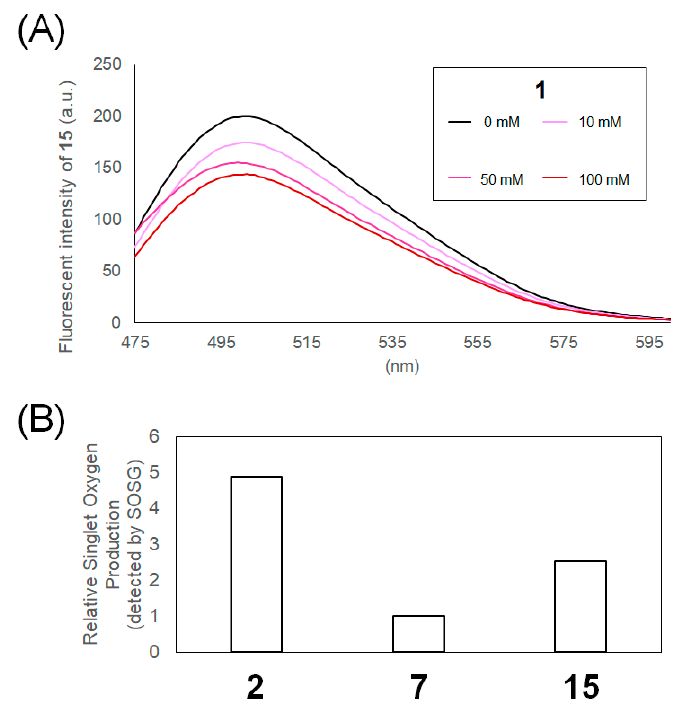
Figure 3. Single-electron transfer (SET) and 1 O 2 production properties of photocatalysts. ( A ) Stern– Volmer fluorescence quenching experiment. Compound 15 (10 nM, in 10% DMSO in 10 mM MES buffer (pH 7.4)) with 0, 10, 50, or 100 mM 1 . ( B ) Relative singlet oxygen production by compounds 2 , 7 , and 15 . See Figure S5 for high-performance liquid chromatography (HPLC) data to detect the oxidized singlet oxygen sensor green (SOSG).